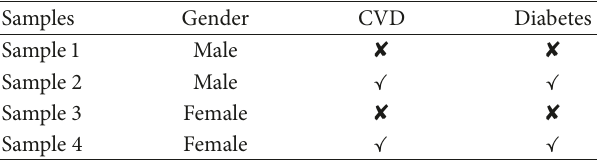
Table 6: Data summary for samples in the longitudinal